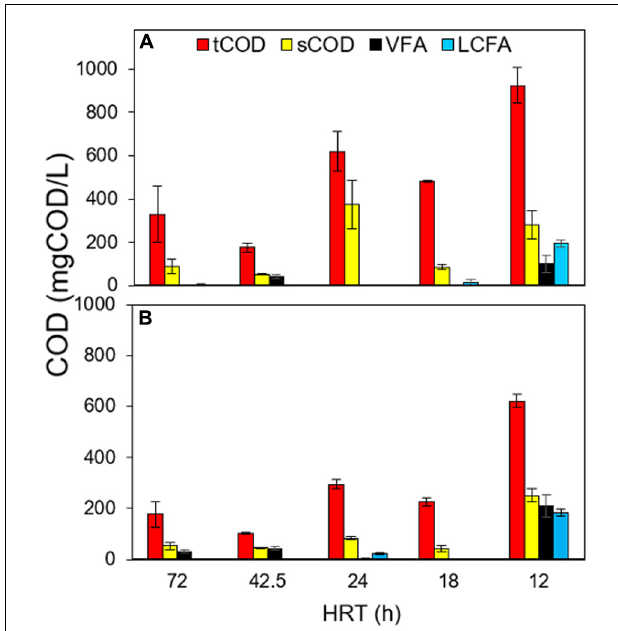
FIGURE 5 | COD fractionation as tCOD, sCOD, VFA-COD and LCFA-COD after treatment by (A) the DSC and further by (B) the FF at the different HRTs of 72, 42.5, 24, 18, and 12 h.